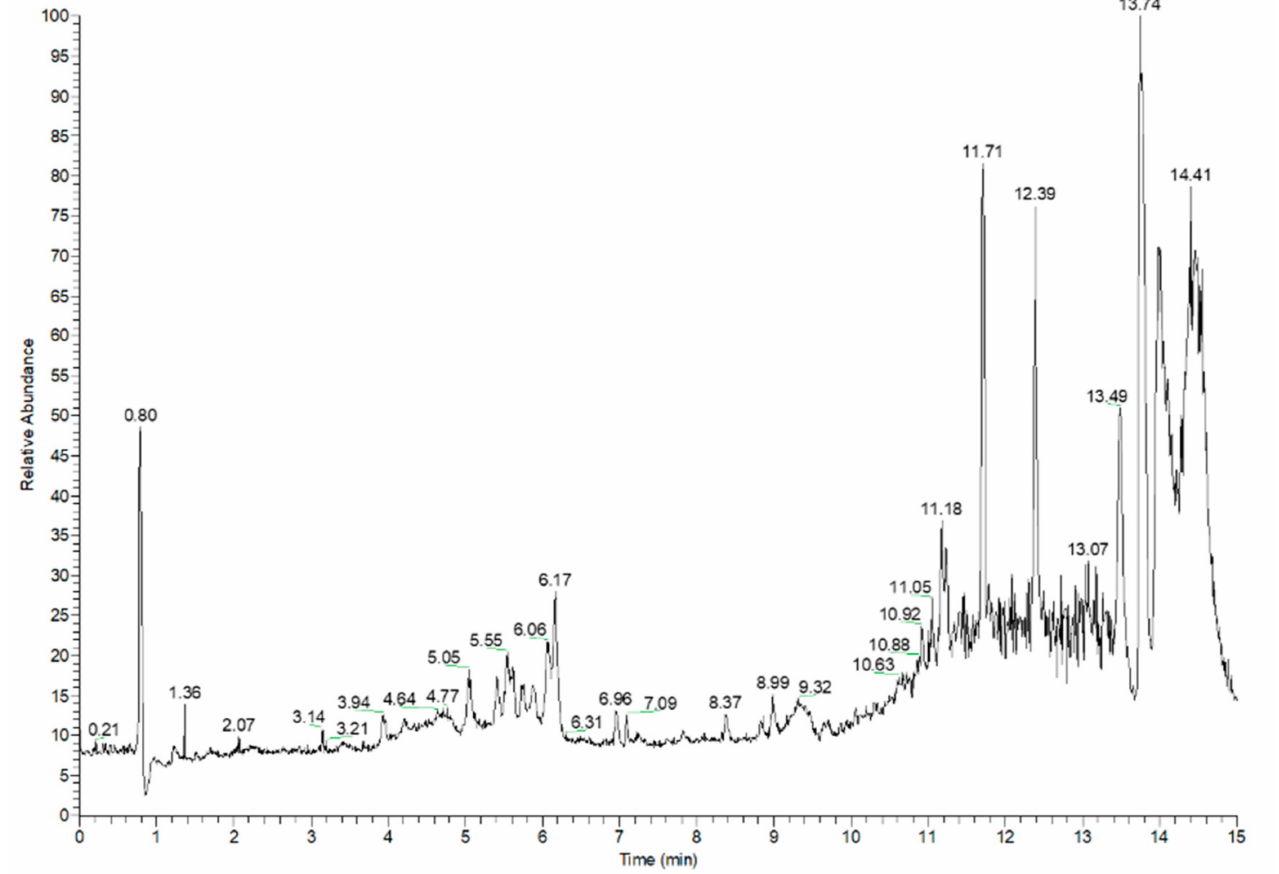
Figure 2. Total ion chromatogram of